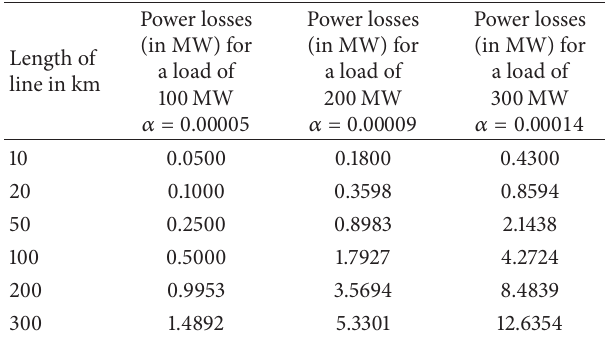
Table 2: Predicted power losses for a 330 kV single circuit of the typical transmission network.